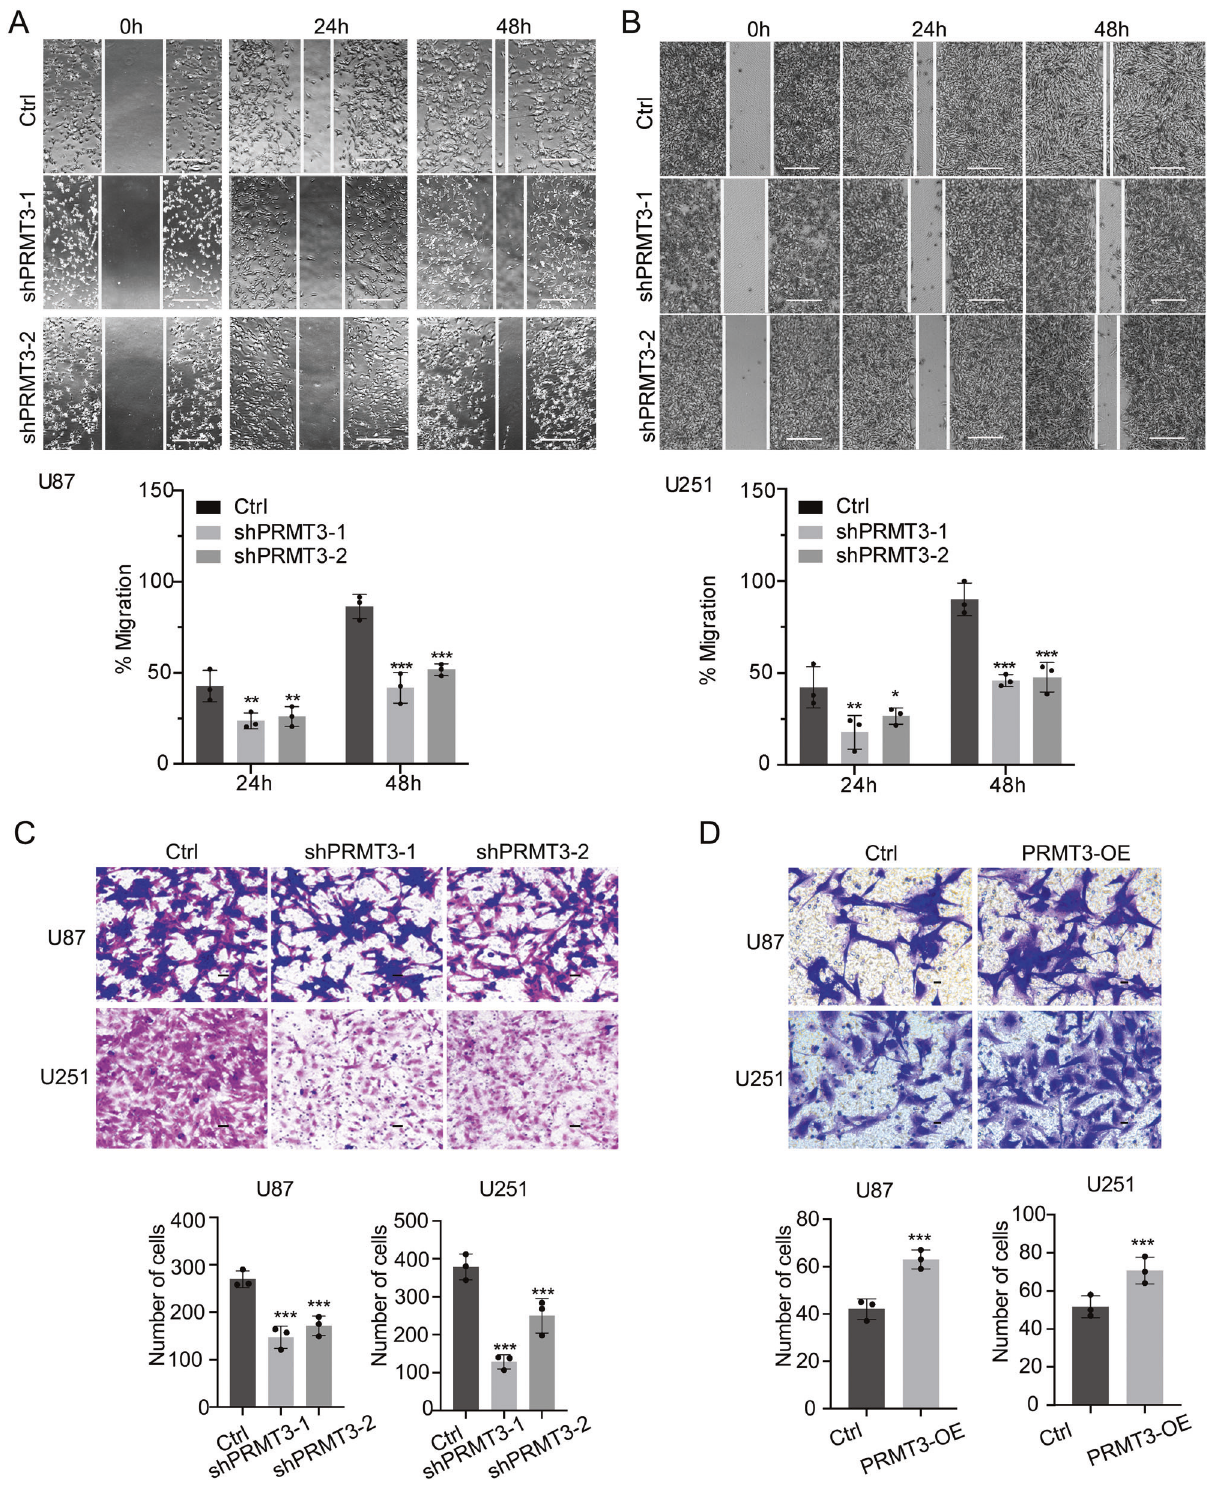
Fig. 4 PRMT3 is required for GBM cell migration. A , B Scratch assays (upper) and quanti fi cation (bottom) of Ctrl and PRMT3-KD U87 ( A ) and U251 ( B ) cell lines. C Representative images of migrating cells of U87 or U251 treated with Ctrl and PRMT3 shRNA with 48 hr followed by the Boyden chamber invasion assay for 72 hours. Area per fi eld, 1 mm 2 . Scale bar, 100 μ m (upper). Quanti fi cation of invasive cells of U87 or U251Ctrl and PRMT3 KD cells (bottom). D Upper, representative images of migrating cells of U87 or U251 transduced with Ctrl and PRMT3-OE following 72 hours in the Boyden chamber invasion assay; Bottom, Quanti fi cation of invasive cells. Area per fi eld, 1 mm 2 . Scale bar, 50 μ m. Data are presented as means ± SEM; n = 3 independent experiments; * p < 0.05; ** p < 0.01; *** p < 0.001; two-tailed unpaired Student t-test (in D ) or one-way ANOVA with multiple comparison test (in A – C